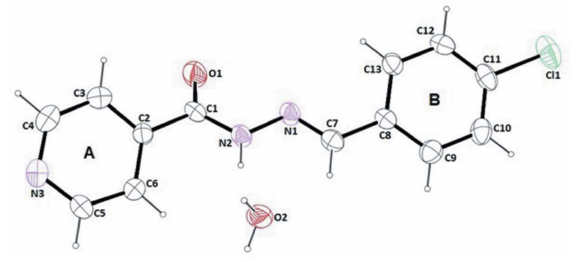
Table 1 Hydrogen-bond geometry (A˚ , (cid:3) ).